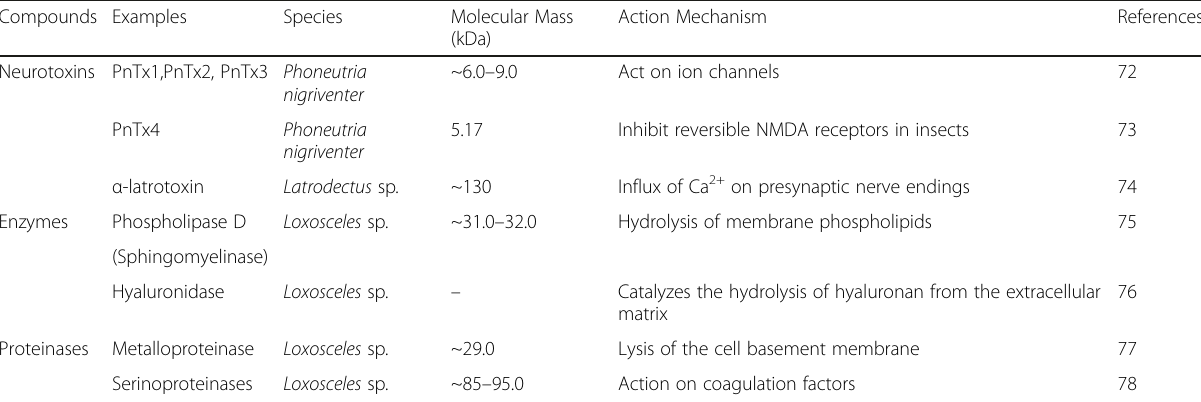
Table 2 Examples of compounds from Brazilian spider venoms Compounds